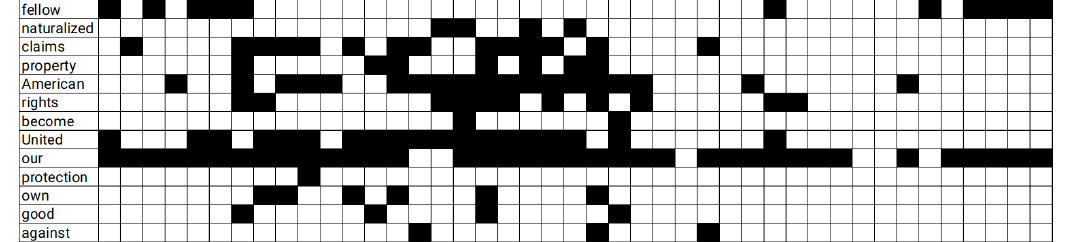
Figure 6. Consistent-collocates on the timeline (each box representing a president’s sub-corpus).